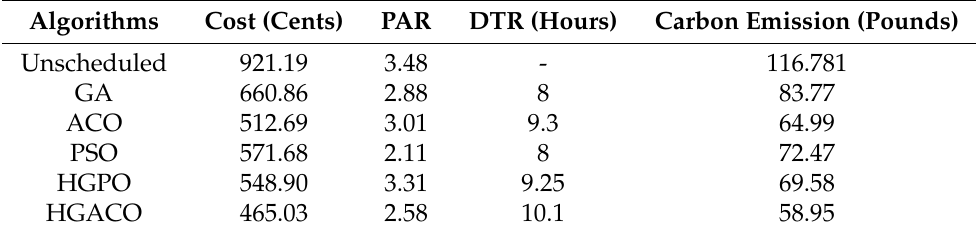
Table 15. Scenario I: performance tradeoff analysis of the proposed and existing algorithms without photovoltaic-battery systems.